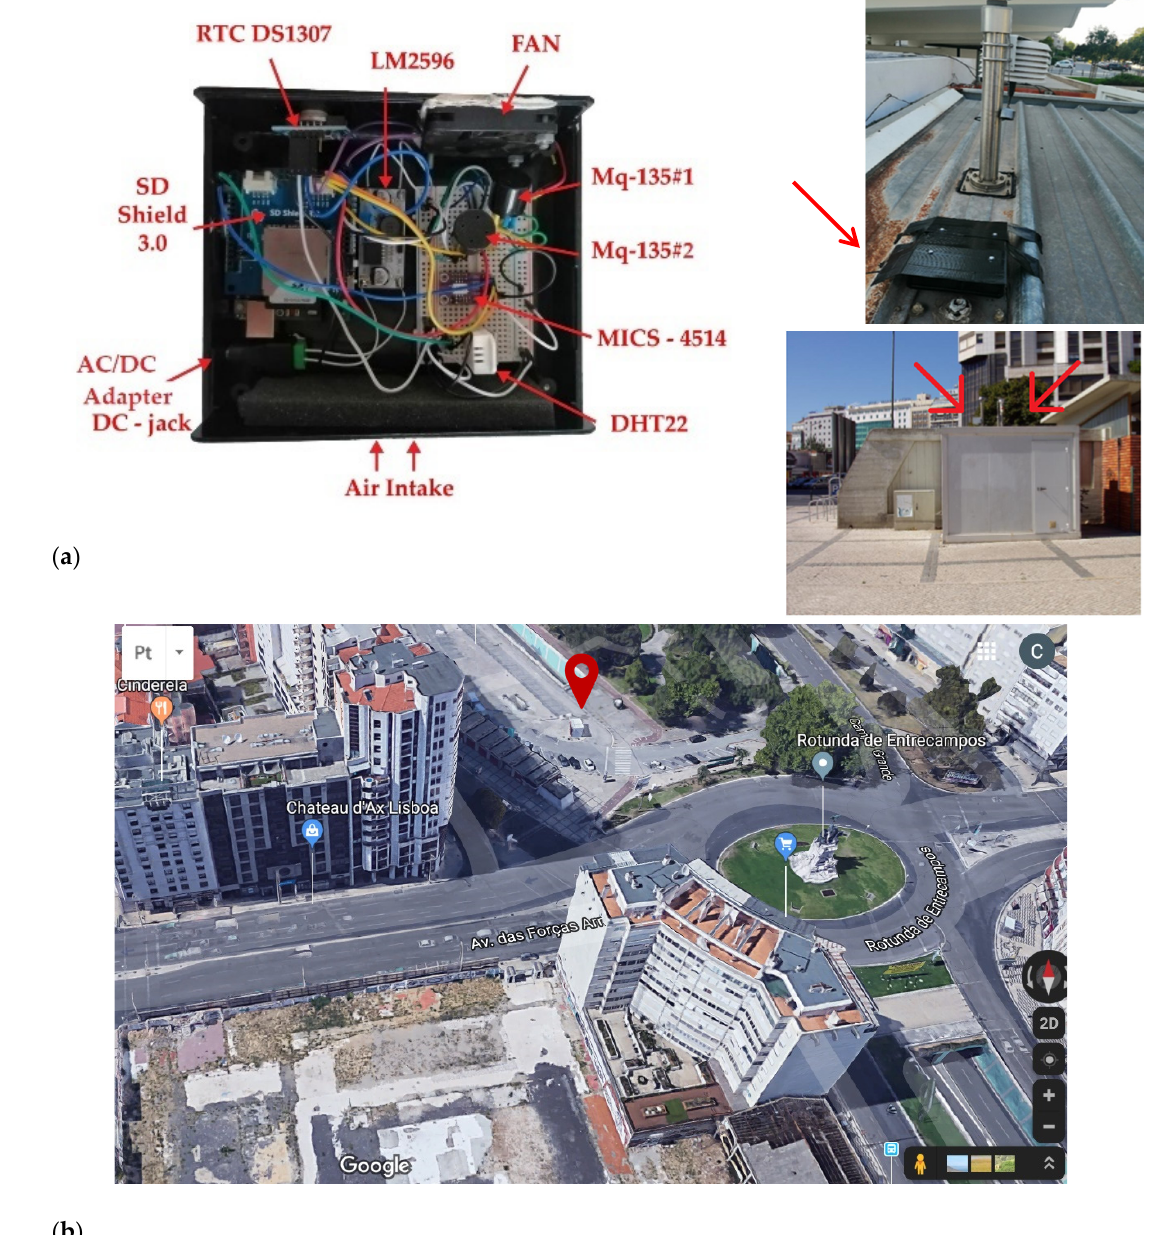
Figure 2. ( a ): Image of the prototype and subsequent mounting location on top of a reference air quality system (AQS); ( b ): Overview of the AQS location near the “Rotunda de Entrecampos”.